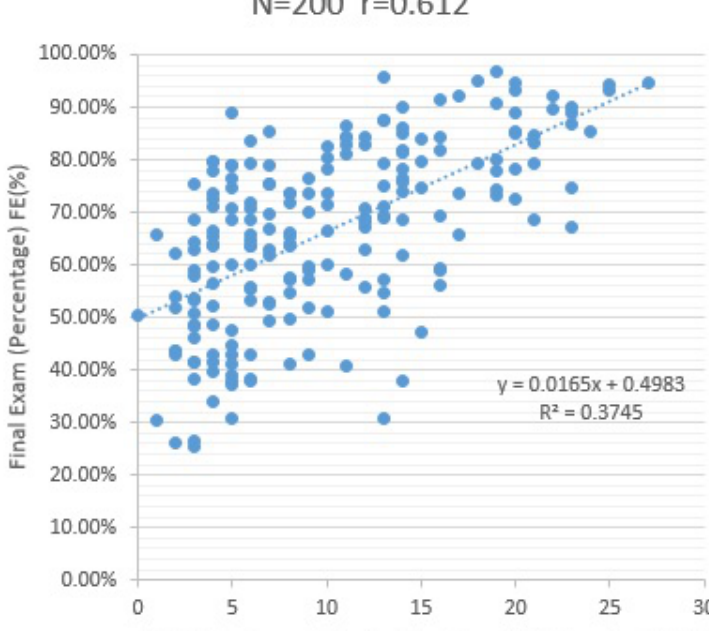
Figure 3. Scattergram showing the correlation between MTL1A and FE for N=200. As Figure 3 indicates, there is a strong positive correlation (r = 0.612) between the number of Mastery Test Level 1 Attempts (MTL1A, max=30) and the Final Exam test score (FE, max=100%). The independent variable MLT1A explains 37.5% of the variability in the FE variable (Table A1). For comparison, we looked at the correlation between the Midterm Exam test score (ME) and the Final Exam test score